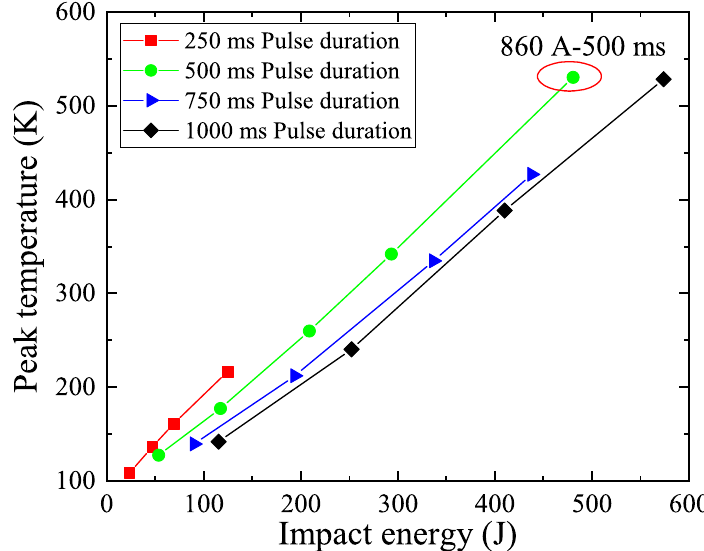
Figure 7. Peak temperature of the HTS tape, calculated by the peak resistance, as a function of the impact energy. The pulse durations of 250 ms, 500 ms, 750 ms and 1000 ms are compared. The peak temperature value of a supplementary experiment in the red circle will be discussed later.